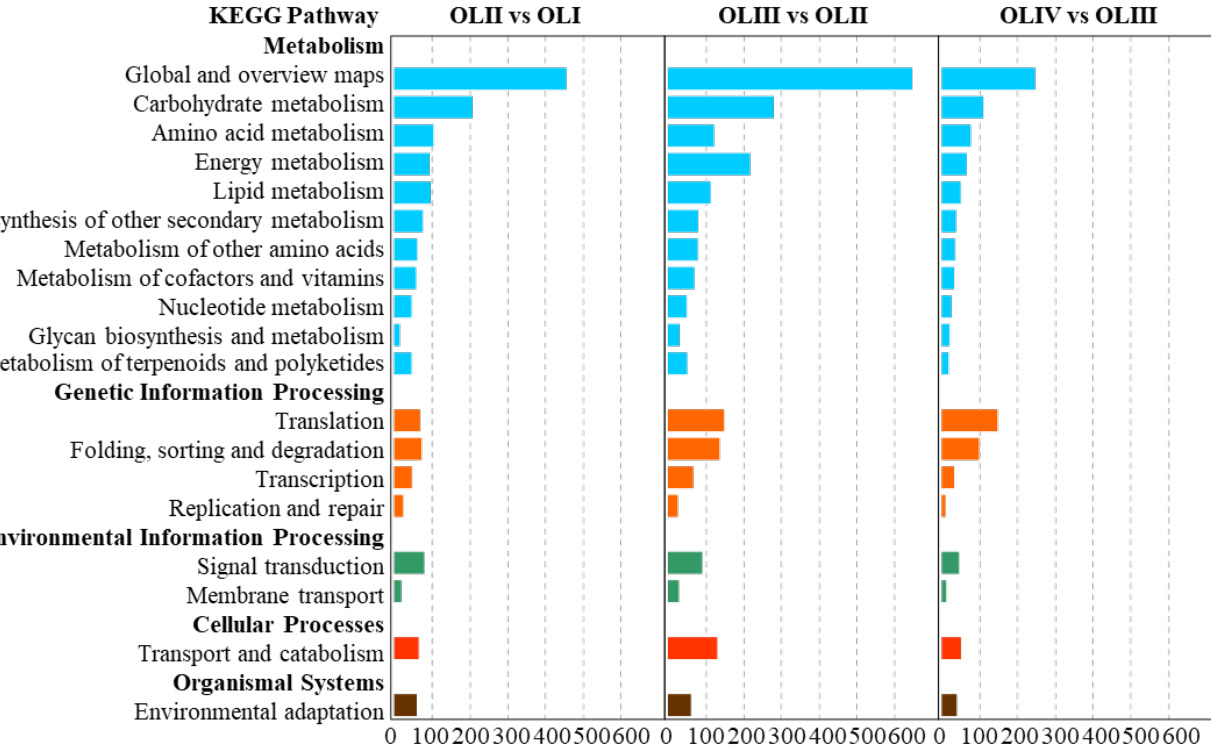
Figure 5. KEGG pathway enrichment analysis of the significantly differentially expressed genes of old leaves in diverse pairwise comparisons.